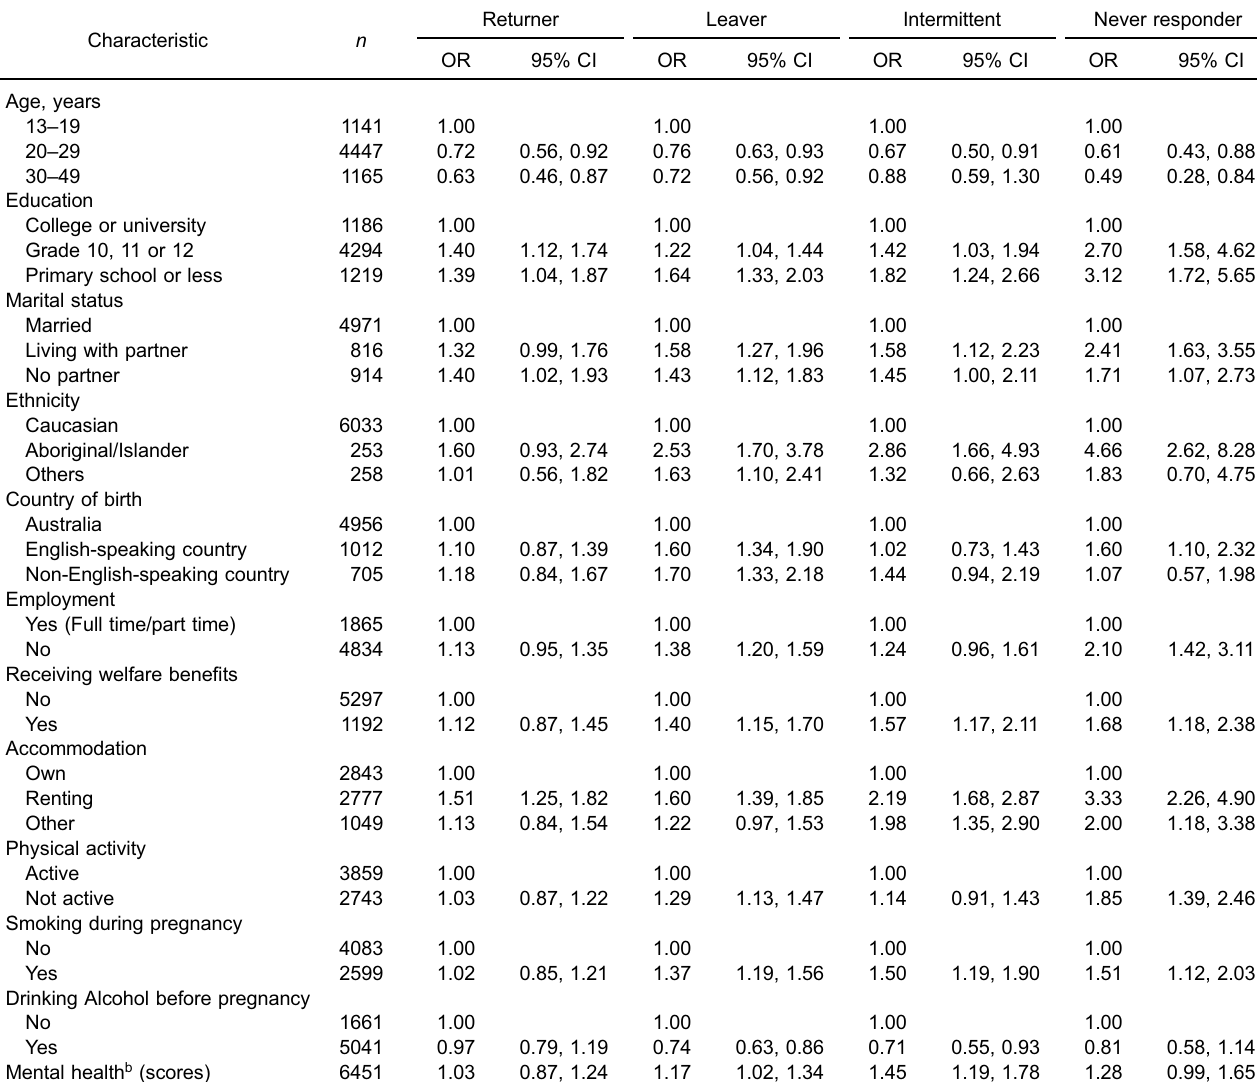
Table 2. Baseline predictors (adjusted ORs) of different patterns of loss to follow-up a